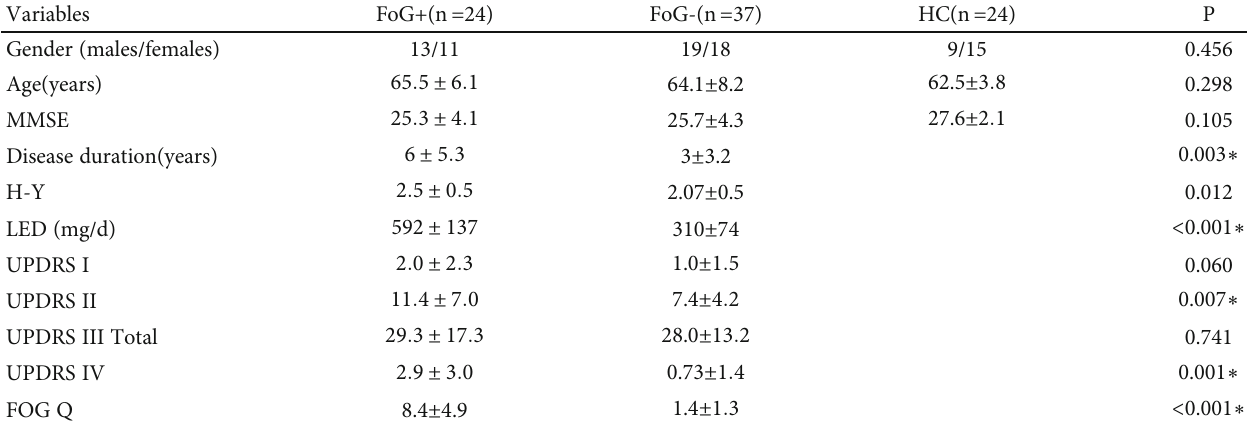
Table 1: Demographics and Clinical evaluations of 3 groups of